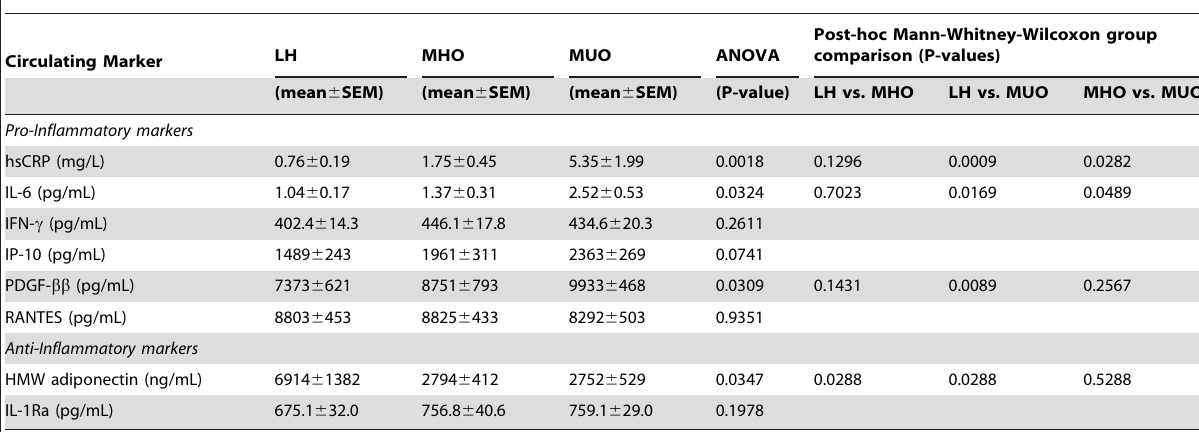
Table 2. Mean circulating concentration of inflammatory markers.